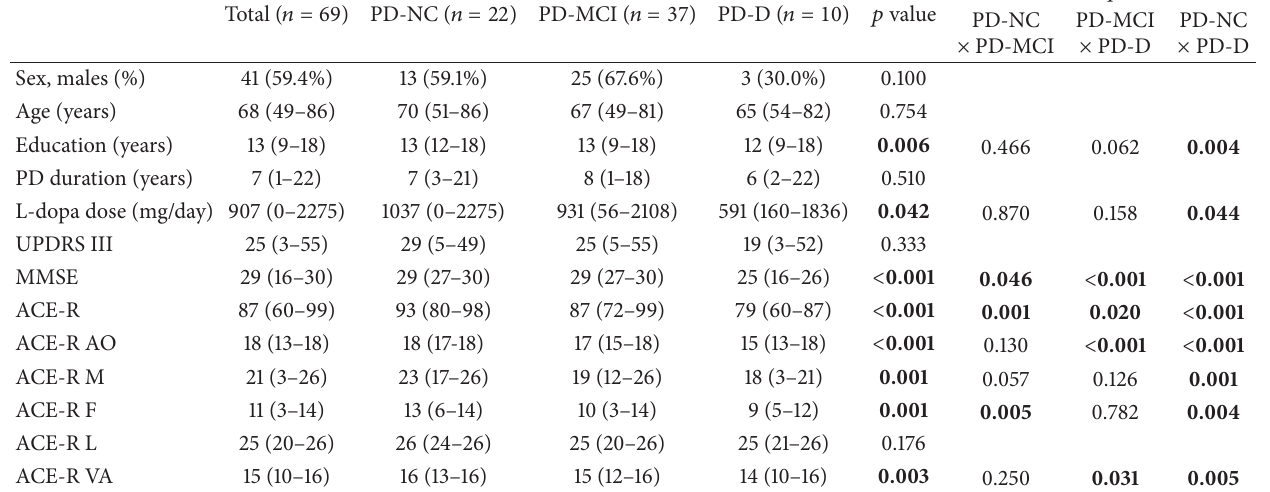
Table 1: Patient characteristics ( 𝑛 = 69 ). Characteristics are described as median